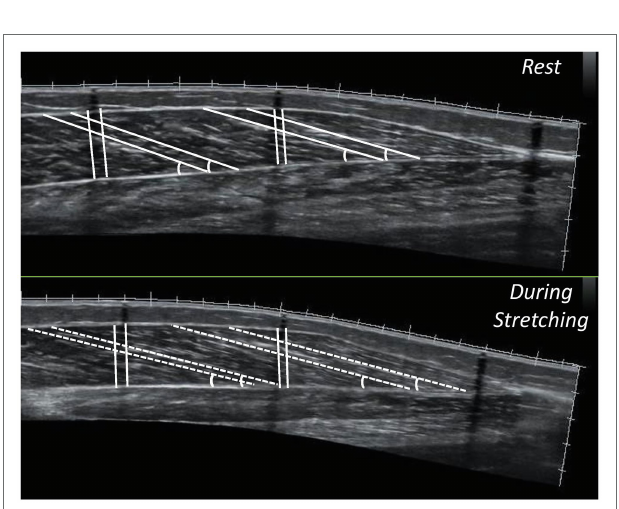
FIGURE 3 | Panoramic sonographic images of gastrocnemius medialis showing fascicle length, pennation angle and muscle thickness, at the middle (MP) and the distal part (DP) of the muscle of the same athlete ( top panel : at rest, bottom panel : during